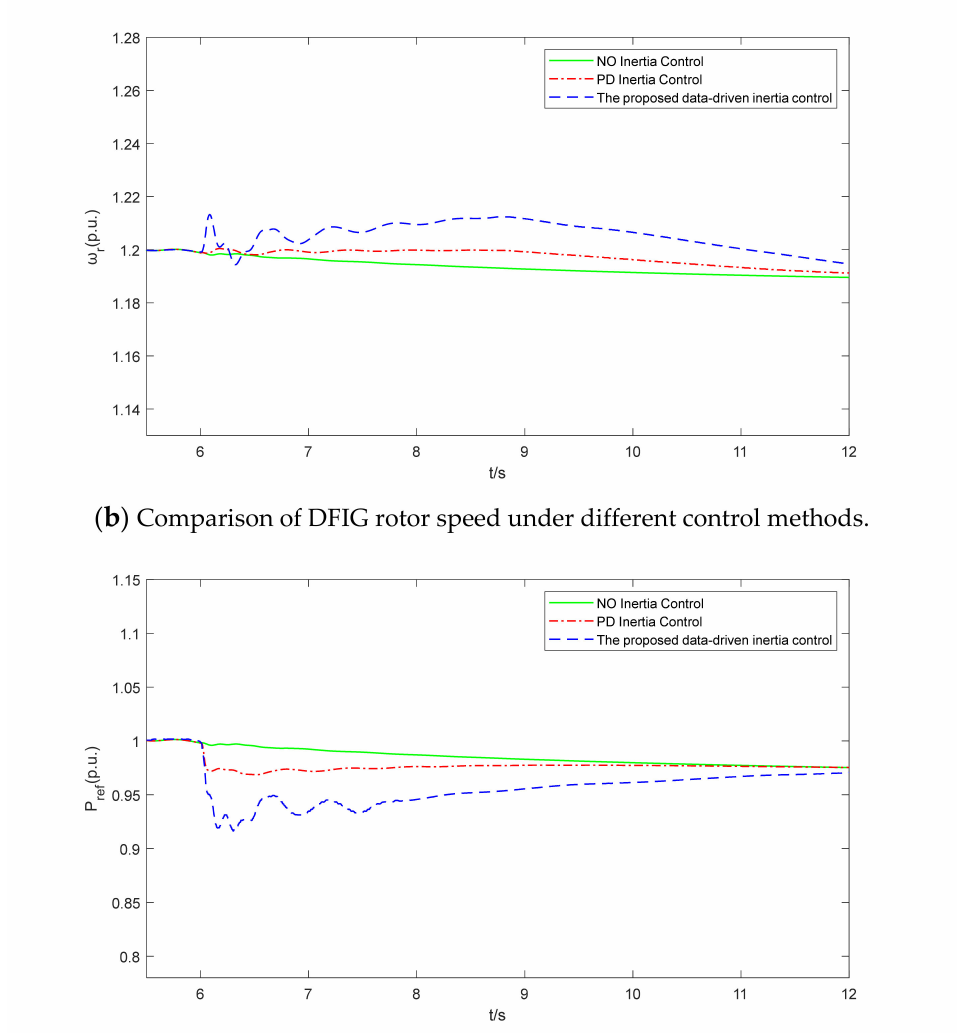
Figure 7. Simulation results of power system when frequency